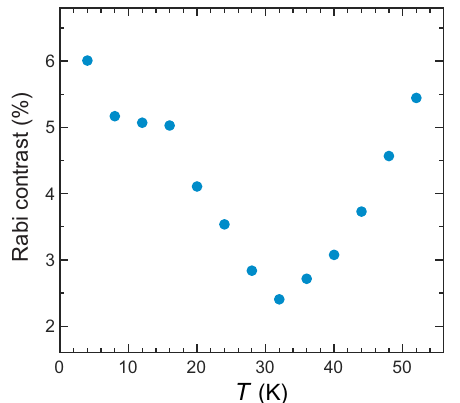
FIG. 7. AFM-determined thickness versus layer number. Each data point is labeled by its flake name (e.g., Flake A, Flake B, Flake C, ...). Flake D contains two well-defined step heights.